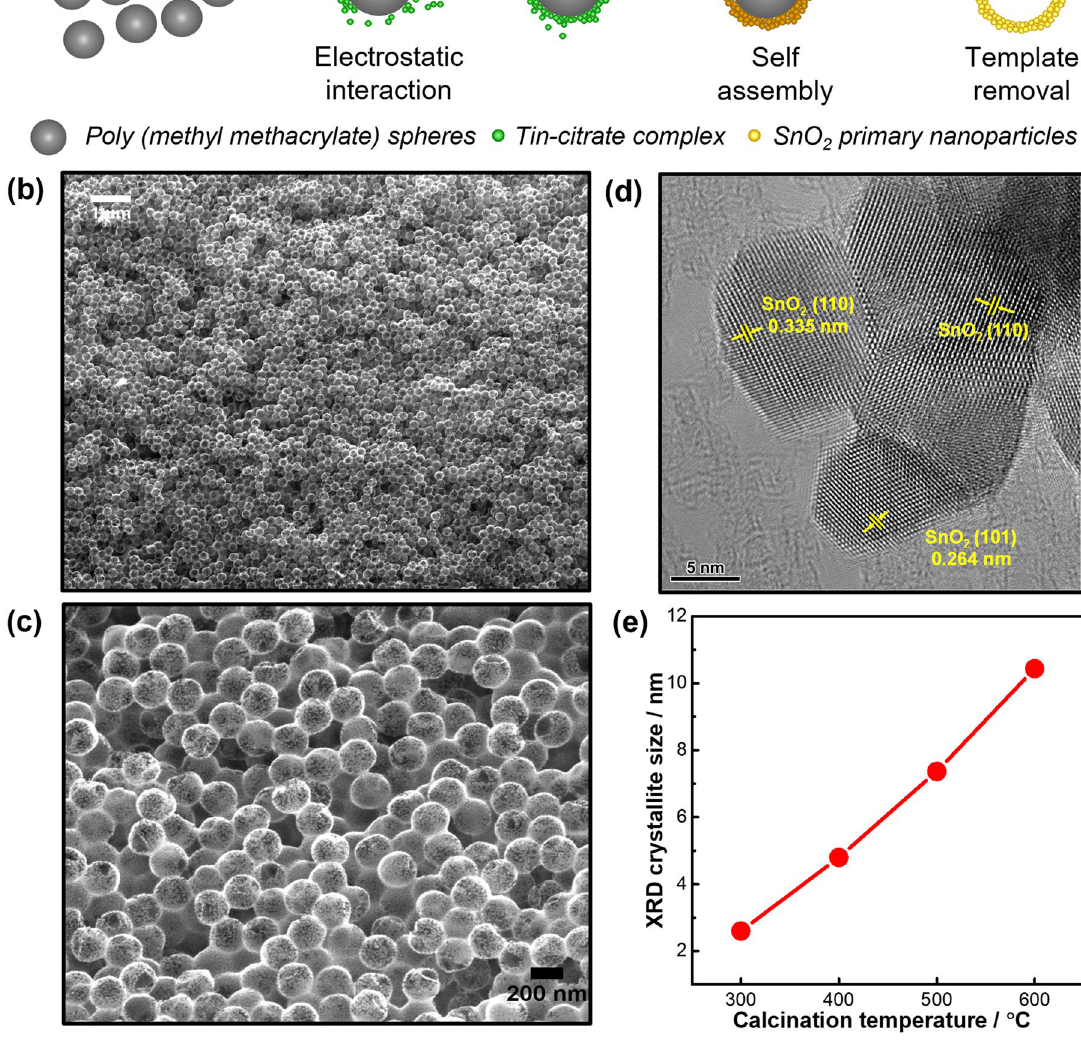
Figure 1. ( a ) Scheme illustrating the synthesis of 3D hollow SnO 2 nanospheres by a combined sol–gel and templating method. ( b , c ) Representative FE-SEM and ( d ) HR-TEM images of SnO 2 nanosphere calcined at 500 °C. ( e ) XRD crystallite size as function of calcination